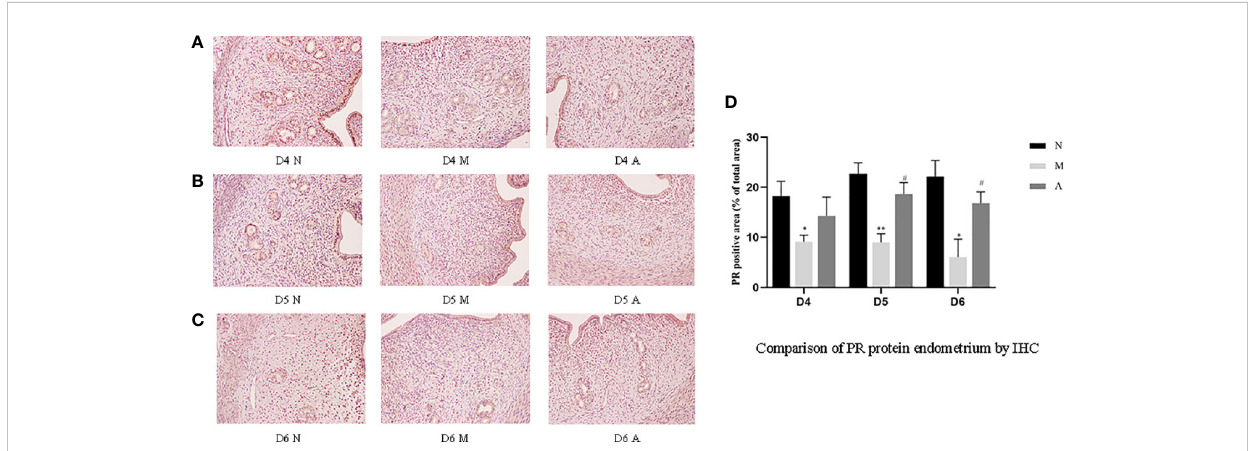
FIGURE 10 The expression of endometrial PR protein: (A) D4; (B) D5; (C) D6; and (D) comparison of PR protein by mean gray value (n=3). *or** represents that there is signi fi cant difference between M and N groups ( P < 0.05 or P < 0.01), #or ## represents that there is signi fi cant difference between A and M groups ( P < 0.05 or P < 0.01). Original magni fi cation *200. PR: Progesterone receptor; IHC, Immunohistochemistry; D, The embryo day; D4 N, D4 normal group; D4 M, D4 model group; D4 A, D4 acupuncture group; D5 N, D5 normal group; D5 M, D5 model group; D5 A, D5 acupuncture group; D6 N, D6 normal group; D6 M, D6 model group; D6 A, D6 acupuncture group; N, Normal group; M, Model group; A, Acupuncture